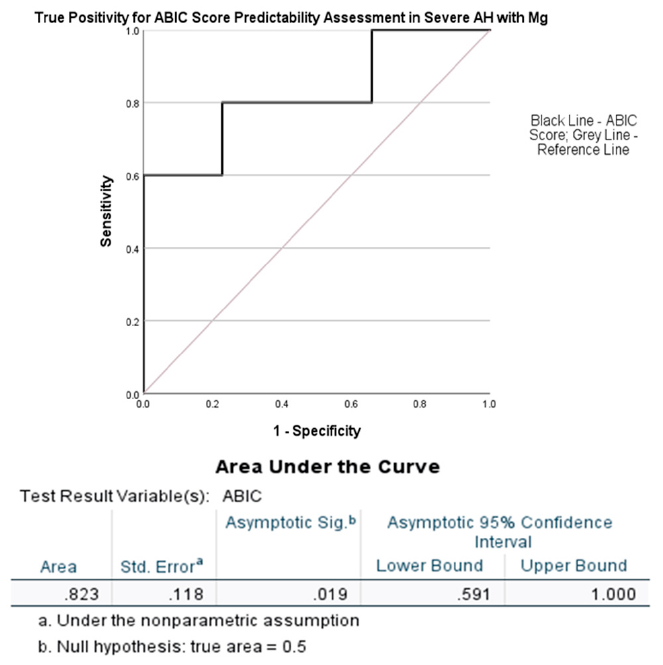
Figure 5. AUROC analysis of ABIC score by the serum magnesium levels (SMg [mmol/L]) at a cutoff of 0.78 mmol/L. Statistical significance was set at p < 0.05.